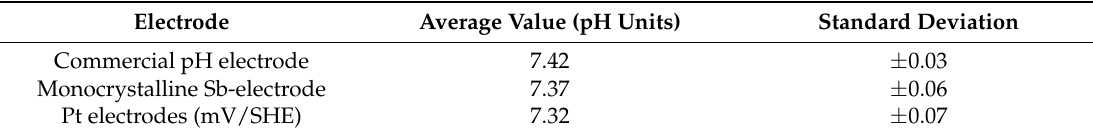
Table 3. Average pH and OCP of Sb electrode measured over 1 month in the reconstituted COx solution in the glove box.